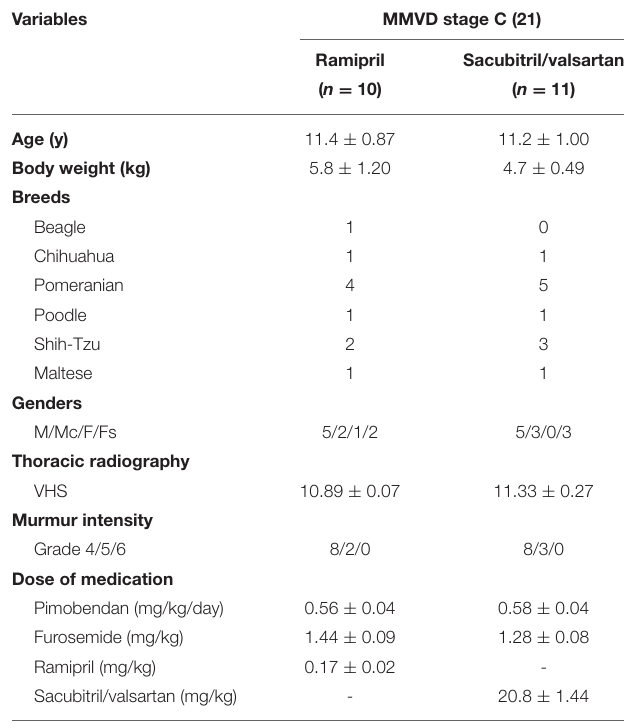
TABLE 1 | Baseline characteristics of the study population dogs with naturally occurring, symptomatic myxomatous mitral valve degeneration.